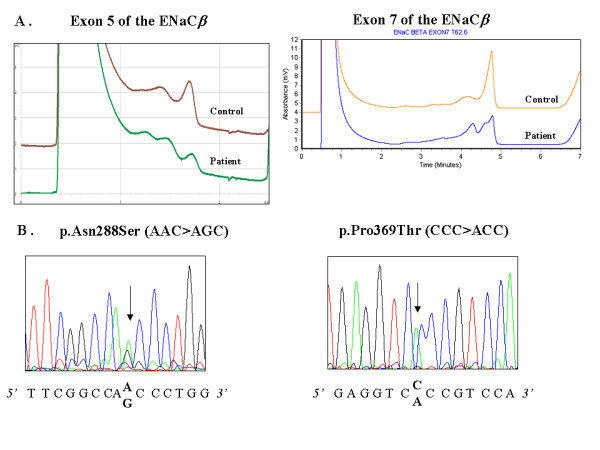
(A) Denaturing high performance liquid chromatography patterns of polymerase chain reaction products corresponding to exon 5 and 7 of ENaCβ : DHPLC profile corresponding to normal exon sequence (control), and altered DHPLC because of a substitution. (B) Fluorescence sequence analysis of exon 5 and exon 7 of the ENaCβ gene, using the forward primer. Arrows indicate position of the p.Asn288Ser and p.Pro369Thr mutations in exon 5 and 7, respectively.